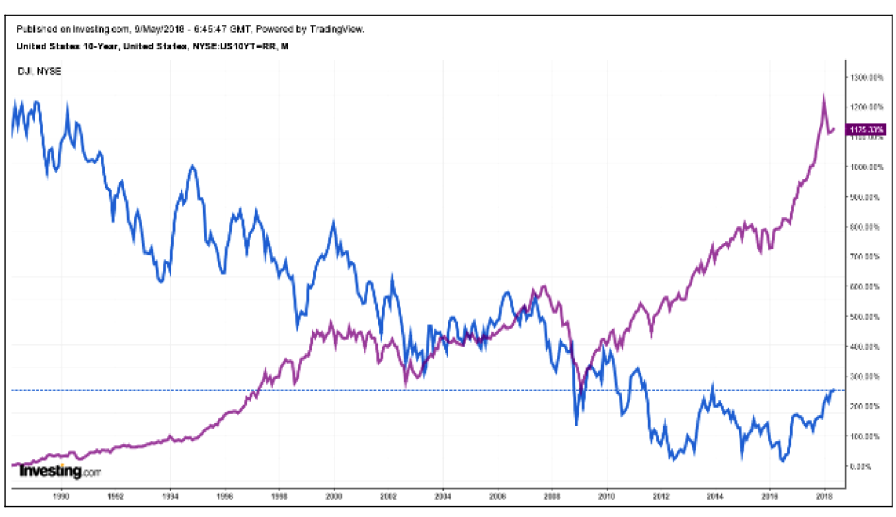
Figure 14. Comparison between DJIA and 10-year US bond (source: own processing created on the website investing.com,